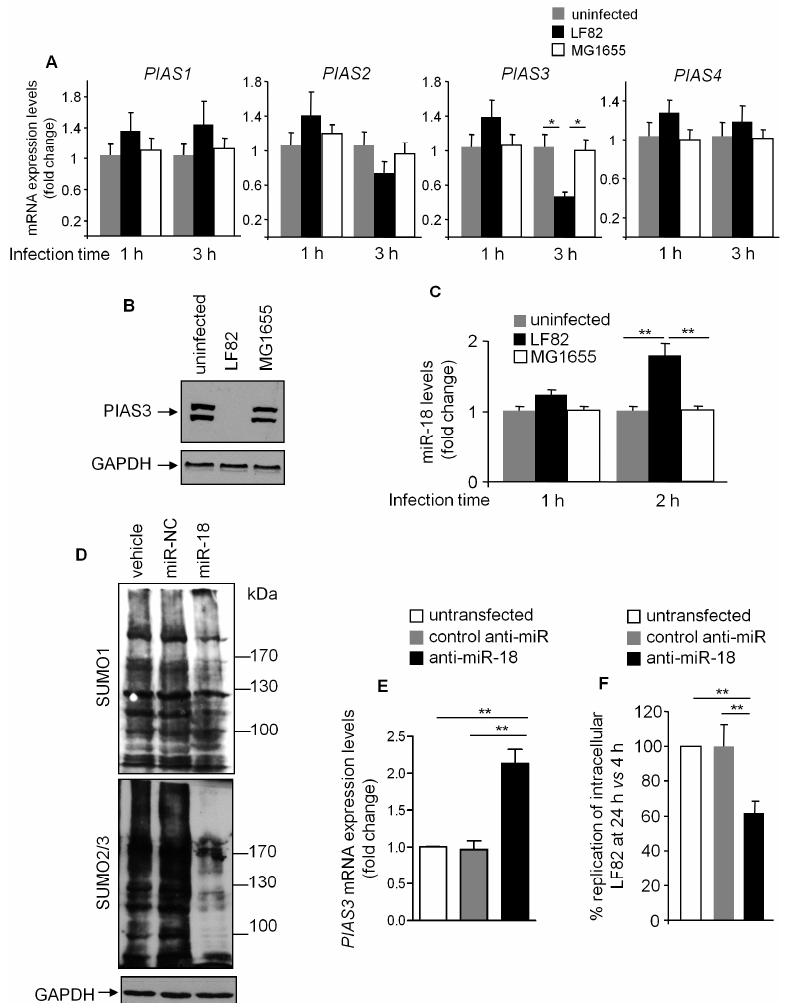
Figure 6. MiR-18 is involved in AIEC-induced deSUMOylation in T84 cells. T84 cells were infected with the AIEC LF82 or the non-pathogenic E. coli MG1655 strain for the indicated time. ( A ) PIAS mRNA expression levels were assessed by qRT-PCR. ( B ) T84 cells were infected for 3 h, and PIAS3 protein level was assessed by Western blot. ( C ) MiR-18 levels were analyzed by qRT-PCR. ( D ) T84 cells were transfected with a precursor of miR-18 or a miRNA-negative control (miR-NC), and SUMO-conjugated protein profile was analyzed by Western blot. ( E, F ) Untransfected T84 cells or cells transfected with anti-miR-18 or a control anti-miR were infected with the LF82 strain. ( E ) PIAS3 mRNA expression level was assessed by qRT-PCR. ( F ) LF82 intracellular number was counted on LB agar plates and is presented as the ratio of intracellular bacteria at 24 h vs. 4 h post-infection, compared to untransfected condition, considered as 100%. Data are means ± SEM of three replicates, and they are representative of three independent experiments. * p < 0.05; ** p ≤ 0.005; *** p ≤ 0.001.